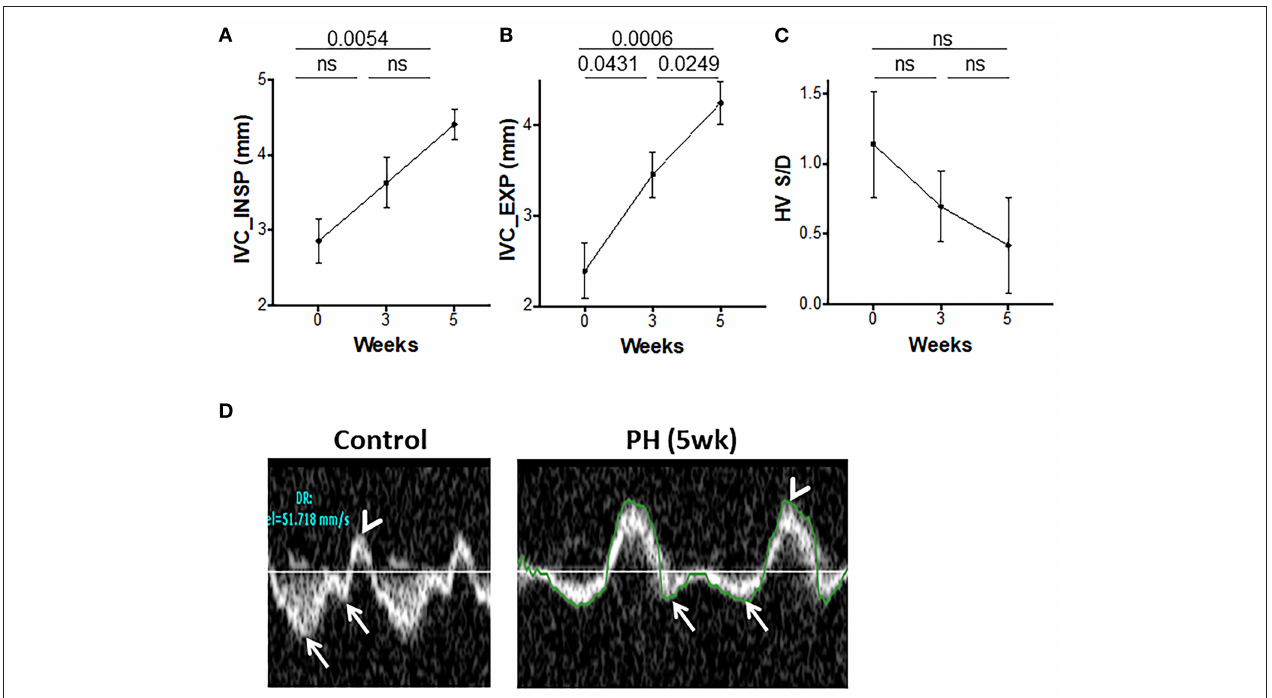
FIGURE 5 | Inferior vena cava (IVC) and hepatic venous flows during progression of PAH. IVC diameters at end inspiration (A) and end expiration (B) and the ratio of hepatic venous systolic to diastolic peak velocities (C) were measured from the subcostal view. (D) Representative echocardiographic images showing hepatic venous flow pattern with a reversal of systolic to diastolic peak velocity ratio (arrows) and prominent atrial reversal peak velocity wave (arrowhead) in control and animals with PH. N = 10